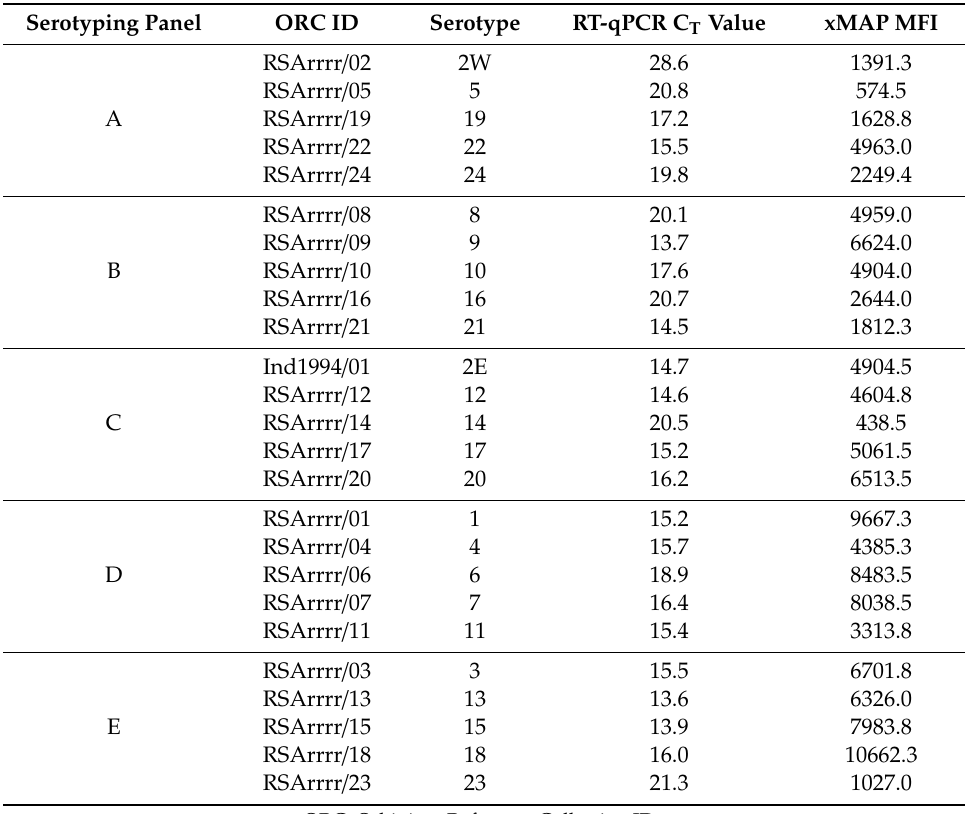
Table 1. Performance of serotype-specific RT-qPCR assay and xMAP assay on BTV reference strains. Serotyping